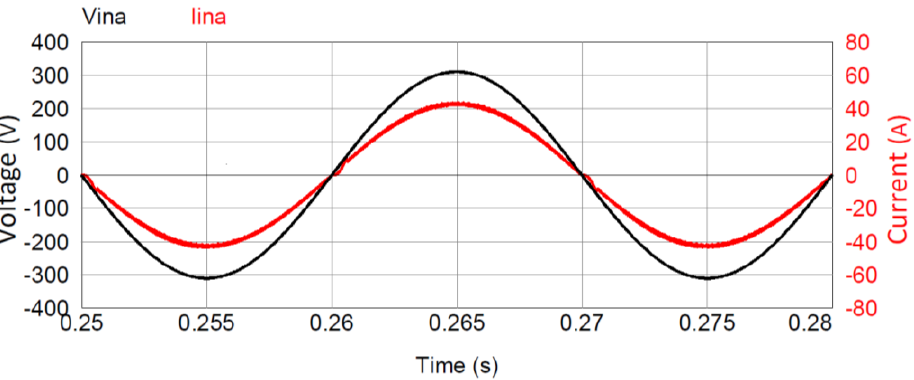
Figure 14. Voltage and currents in phase a, of the rectifier.